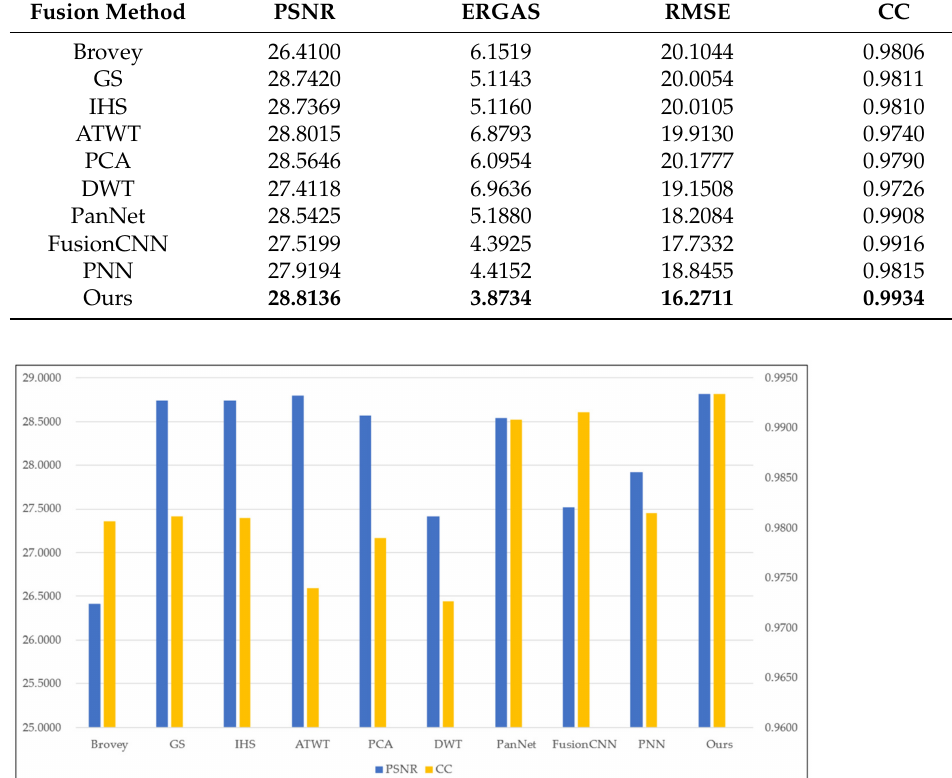
Table 2. The first group evaluation indexes of different fusion results.